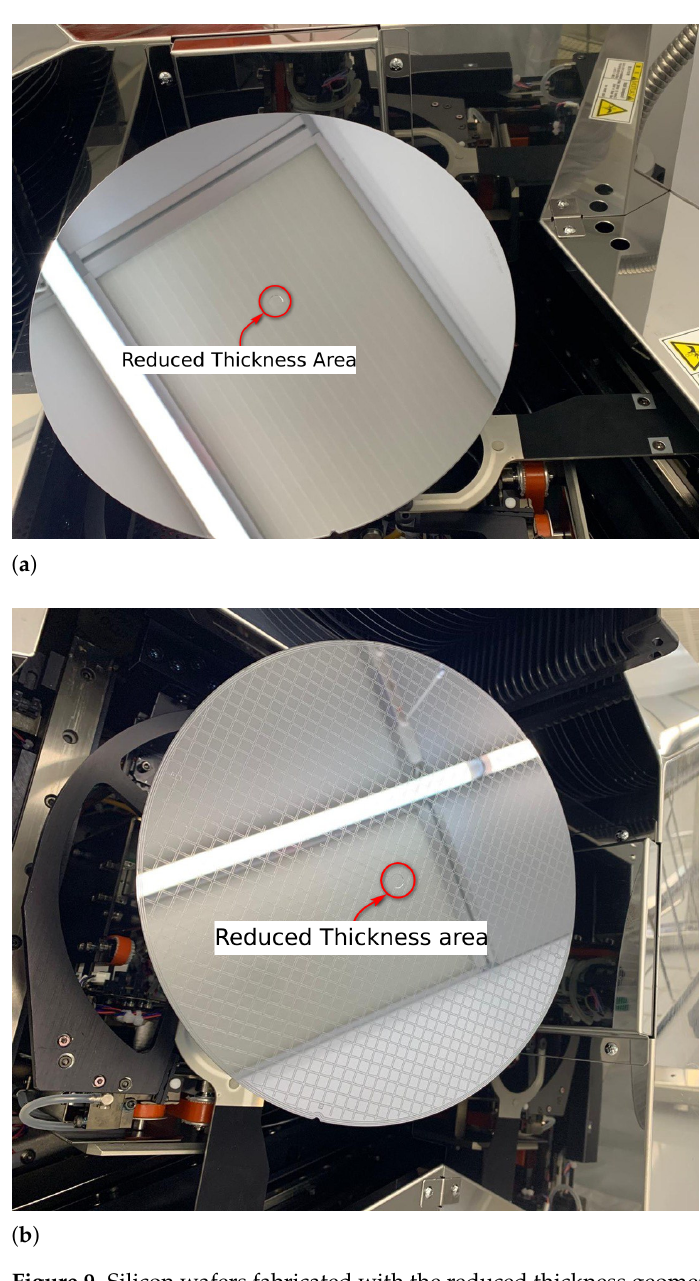
Figure 9. Silicon wafers fabricated with the reduced thickness geometry. ( a ) The reduced thickness area on the supposed to be the microsystem wafer; ( b ) The reduced thickness area on the cap wafer (with glass frit